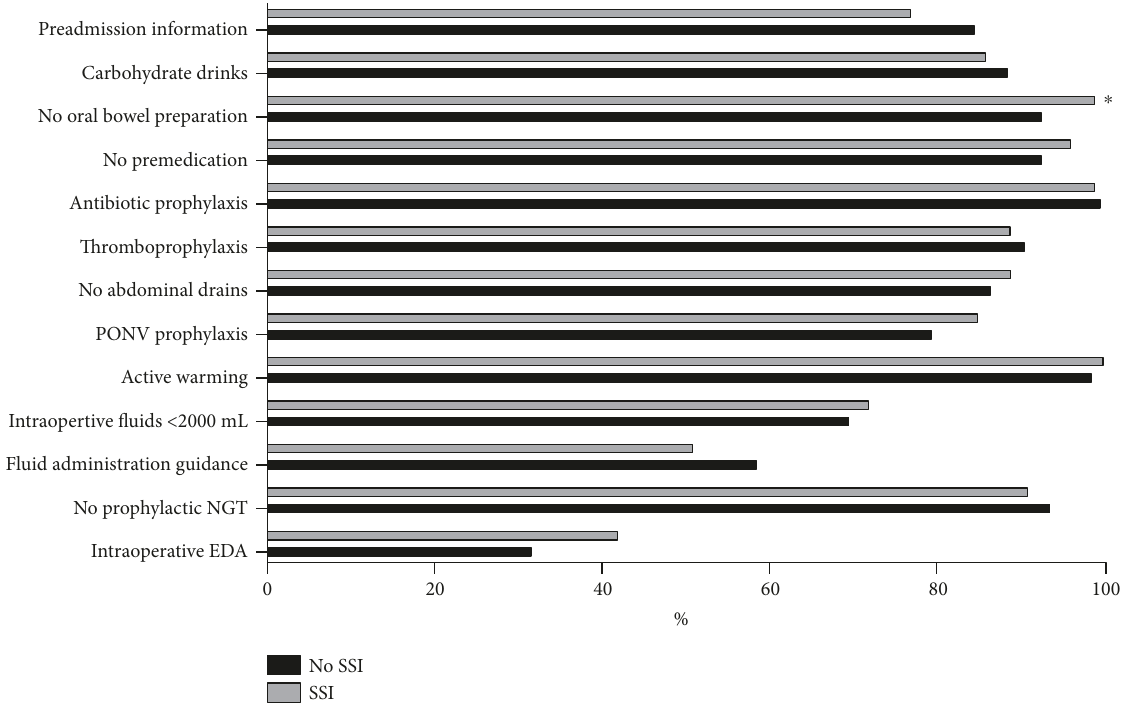
Figure 1: Pre- and intraoperative modi fi able ERAS items. Comparison of compliance to modi fi able pre- and intraoperative ERAS-related items among patients with SSI (black bars) and patients without SSI (grey bars). Premedication = administration of long-acting sedative medication. SSI: surgical site infection; PONV: postoperative nausea and vomiting; EDA: epidural analgesia; NGT: nasogastric tube. ∗ indicates statistical signi fi cance ( p < 0 05 ).